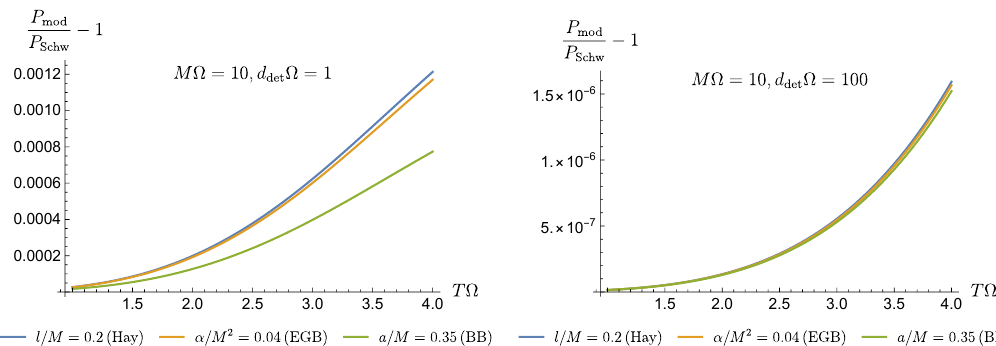
Figure 3 . The probability differences, computed as ratio R = P mod /P Schw − 1 as a function of switching time T . All quantities are measured in units of Ω , but we keep the deformation parameter to be scaled with M (which can be converted to Ω if one likes). We set the mass to be M Ω = 10 . (a) Near horizon regime, with proper distance d det Ω = 1 . (b) Far from black hole regime, with proper distance d det Ω = 100 . The detector response is more sensitive near the black hole in distinguishing the metric functions. In all cases, longer interaction improves the sensitivity of the detector to the deformation parameter.